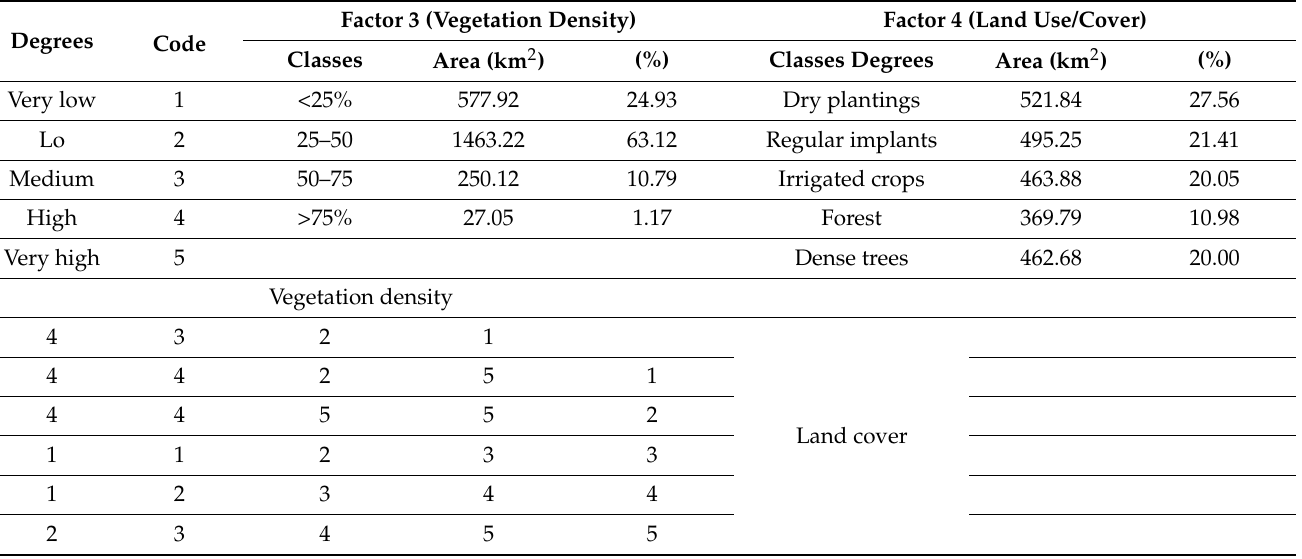
Table 3. Correlation matrix of vegetation density and land cover according to PAP/RAC